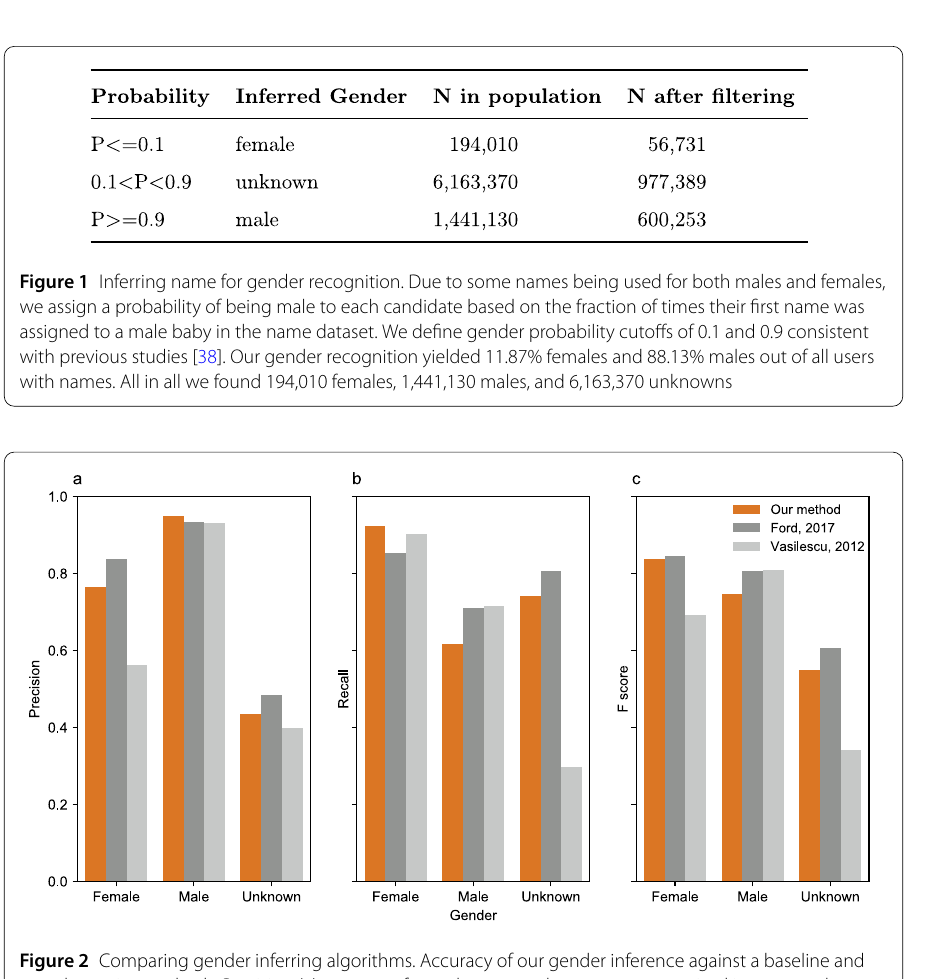
There were 73 cases (12.2%), where the opinion of us, two manual coders differed.